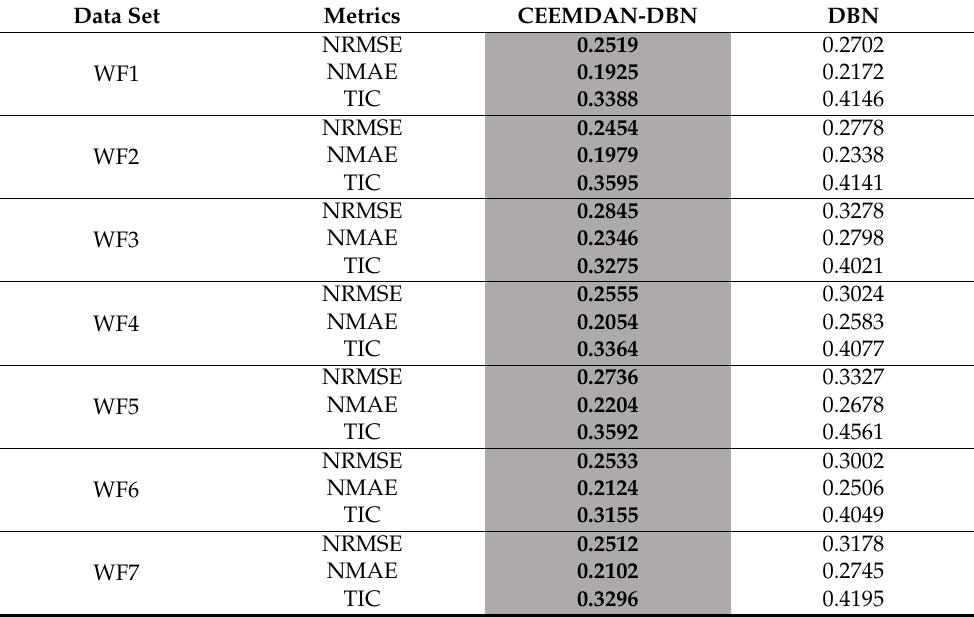
Table 2. The assessments results of DBN and CEEMDAN-DBN on three